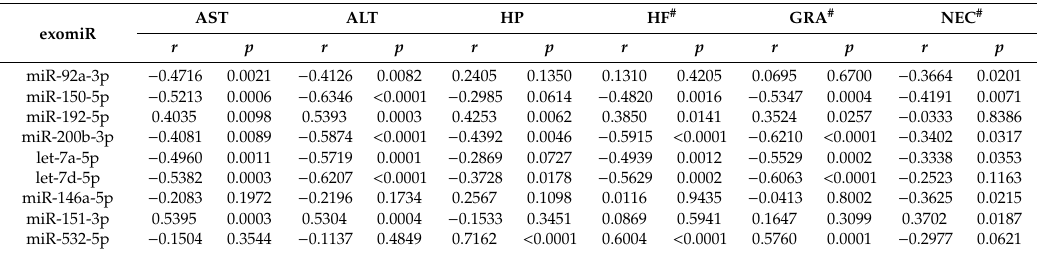
Correlations were analyzed by Pearson’s r ( n = 40). Abbreviations: AST: aspartate aminotransferase; ALT: alanine aminotransferase; HP: hydroxyproline; HF: hepatic fibrosis; GRA: granuloma; NEC: necrosis. # Percentage